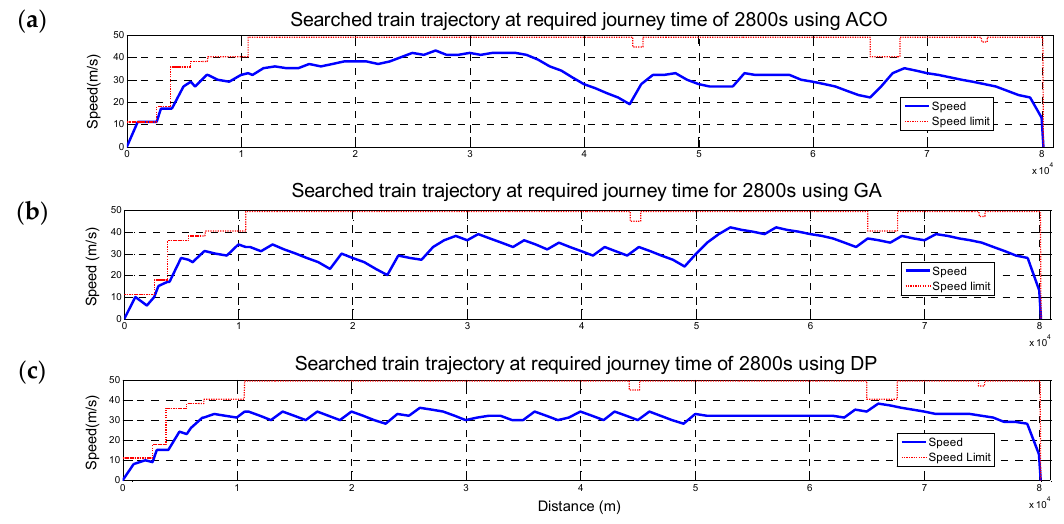
Figure 19. Speed profile optimization by ACO ( a ); GA ( b ); and DP ( c ) of Lu (2011).